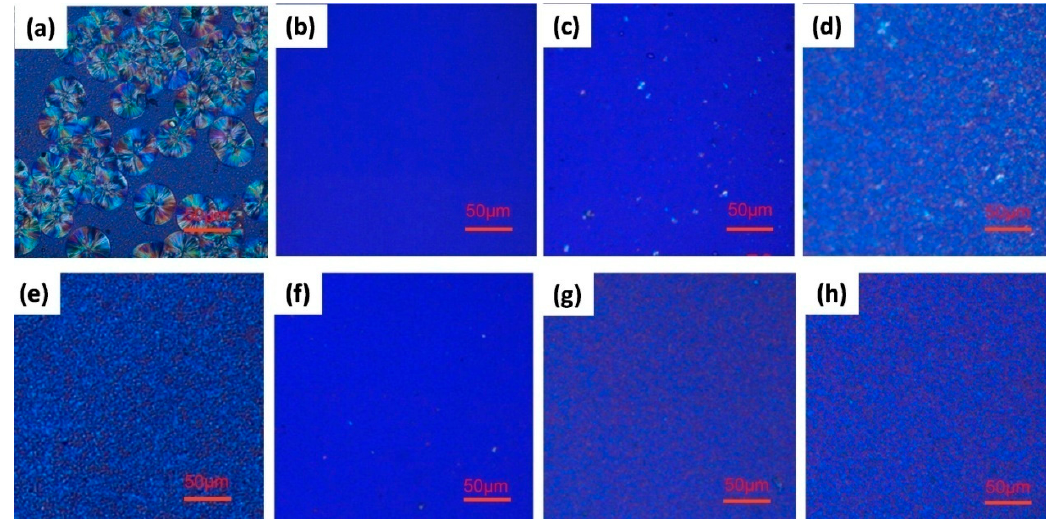
Figure 6. POM results of PLA and PLA / TMC (0.5 wt%): ( a ) PLA (4032D) heated at 130 ◦ C for 30 min, ( b ) PLA (4032D) heated at 210 ◦ C for 10 min, ( c ) PLA (4032D) heated at 30 ◦ C from 210 ◦ C at a rate of 10 ◦ C min − 1 , ( d ) PLA (4032D) heated at 110 ◦ C for 30 min from 30 ◦ C at a rate of 10 ◦ C min − 1 , ( e ) PLA / TMC (0.5 wt%) heated at 130 ◦ C for 30 min, ( f ) PLA / TMC (0.5 wt%) heated at 210 ◦ C for 10 min, ( g ) PLA / TMC (0.5 wt%) heated at 30 ◦ C from 210 ◦ C at a rate of 10 ◦ C min − 1 and ( h ) PLA / TMC (0.5 wt%) heated at 110 ◦ C for 30 min from 30 ◦ C at a rate of 10 ◦ C min − 1